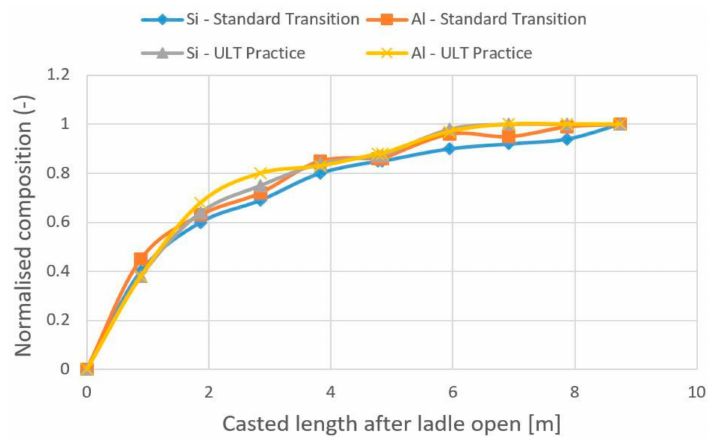
Figure 5. Comparison of transition curves for standard transition and ULT